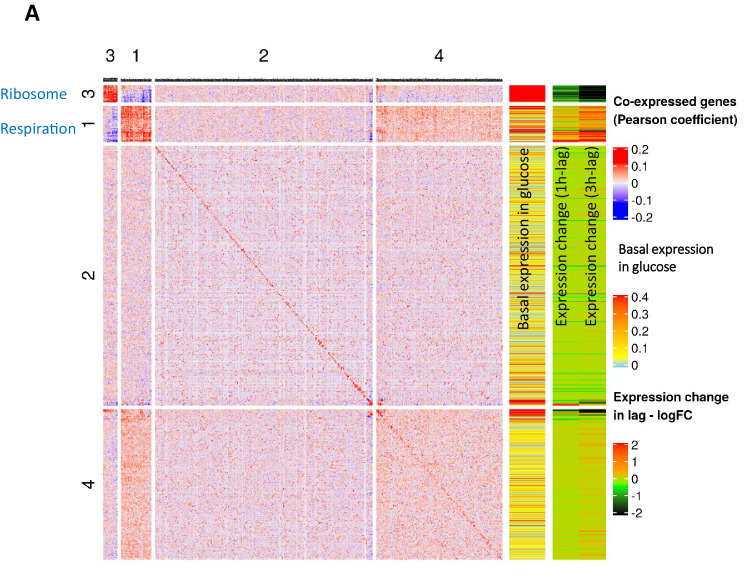
Concurrent analysis of co-expression and expression dynamics during lag phase (lag-1h).(A) Similar to Figure 3A and B but for lag-1h sample. The lists of genes in each of the clusters are provided as Supplementary file 4.